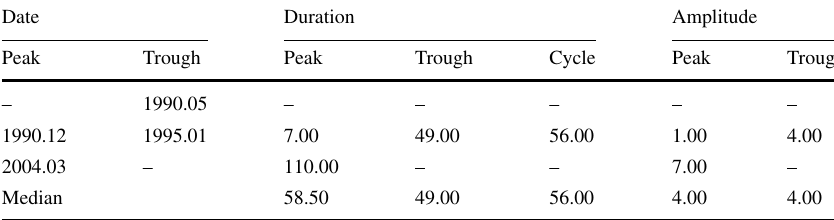
Table 5 Turning points (peaks and troughs) of the output